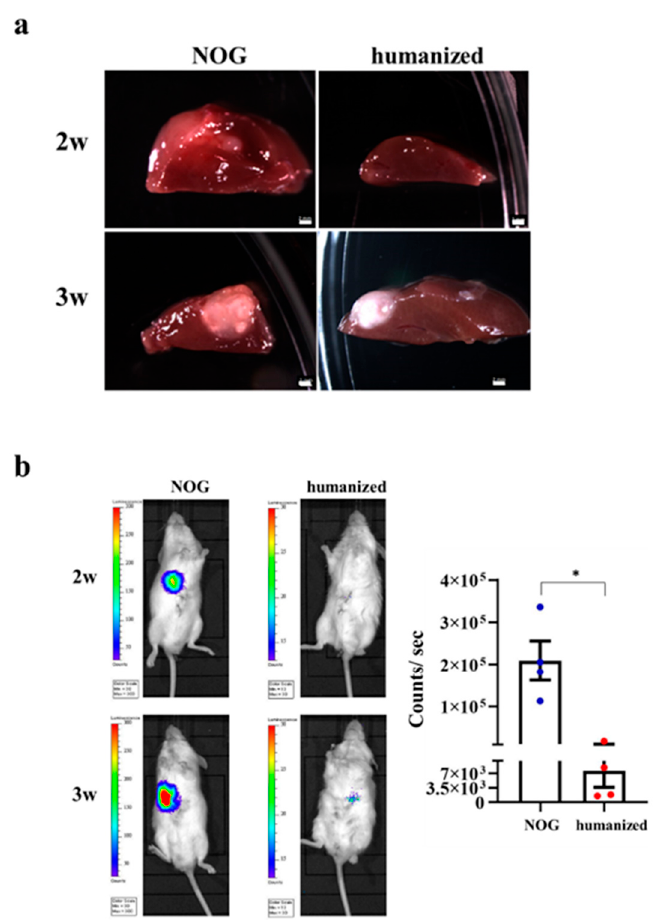
Figure 6. HCC organoid implantation in the humanized mice. ( a ) Morphology analysis on liver tissues from NOG and humanized mice. NOG mice (left), humanized mice (right). The top panel is the result of HO implantation 2 weeks. The bottom panel is the result of HO implantation 3 weeks. Scale bar represents 2 mm. ( b ) BLI of luciferase signal in humanized and NOG mice. Bioluminescence signal is illustrated in pseudo color. Four panels (first top panel: implanted HO into NOG mouse at 2 weeks, second top panel: implanted HO into humanized mouse at 2 weeks, bottom panel means after implantation in the different mouse at 3 weeks. Mann–Whitney U test ( n = 4/group). * p <